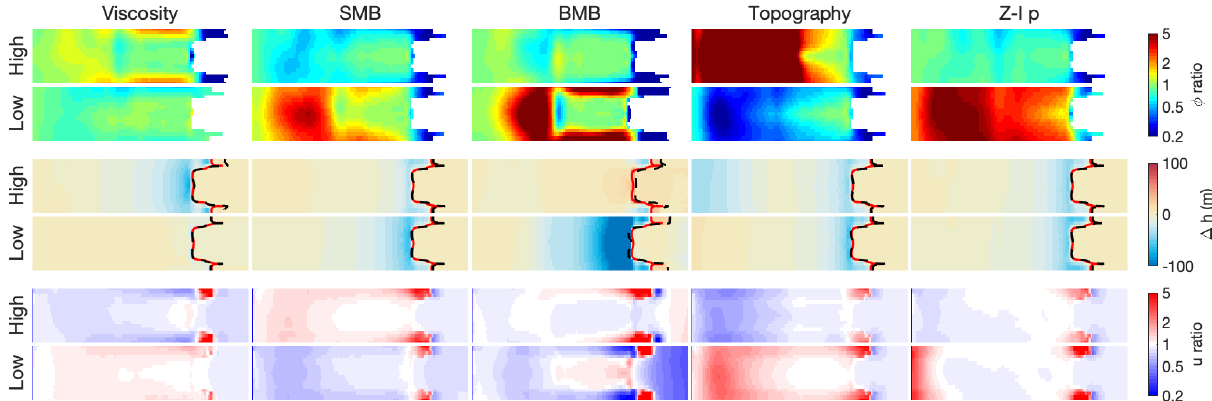
Figure 7. Errors in inverted bed roughness, surface elevation, and surface velocity (relative to the target) for the perturbed inversions of experiment II. The top two rows show the errors in the bed roughness for the high and low perturbed inversions; the middle two rows show the errors in the steady-state surface elevation; and the bottom two rows show the errors in the surface velocity. Each column represents a single perturbed model parameter: viscosity (i.e. Glen’s flow law factor A ), surface mass balance, basal mass balance, subglacial topography, and the Zoet–Iverson sliding law exponent p . The grounding line in the target (inverted) geometry is indicated by a solid red (dashed black) line.